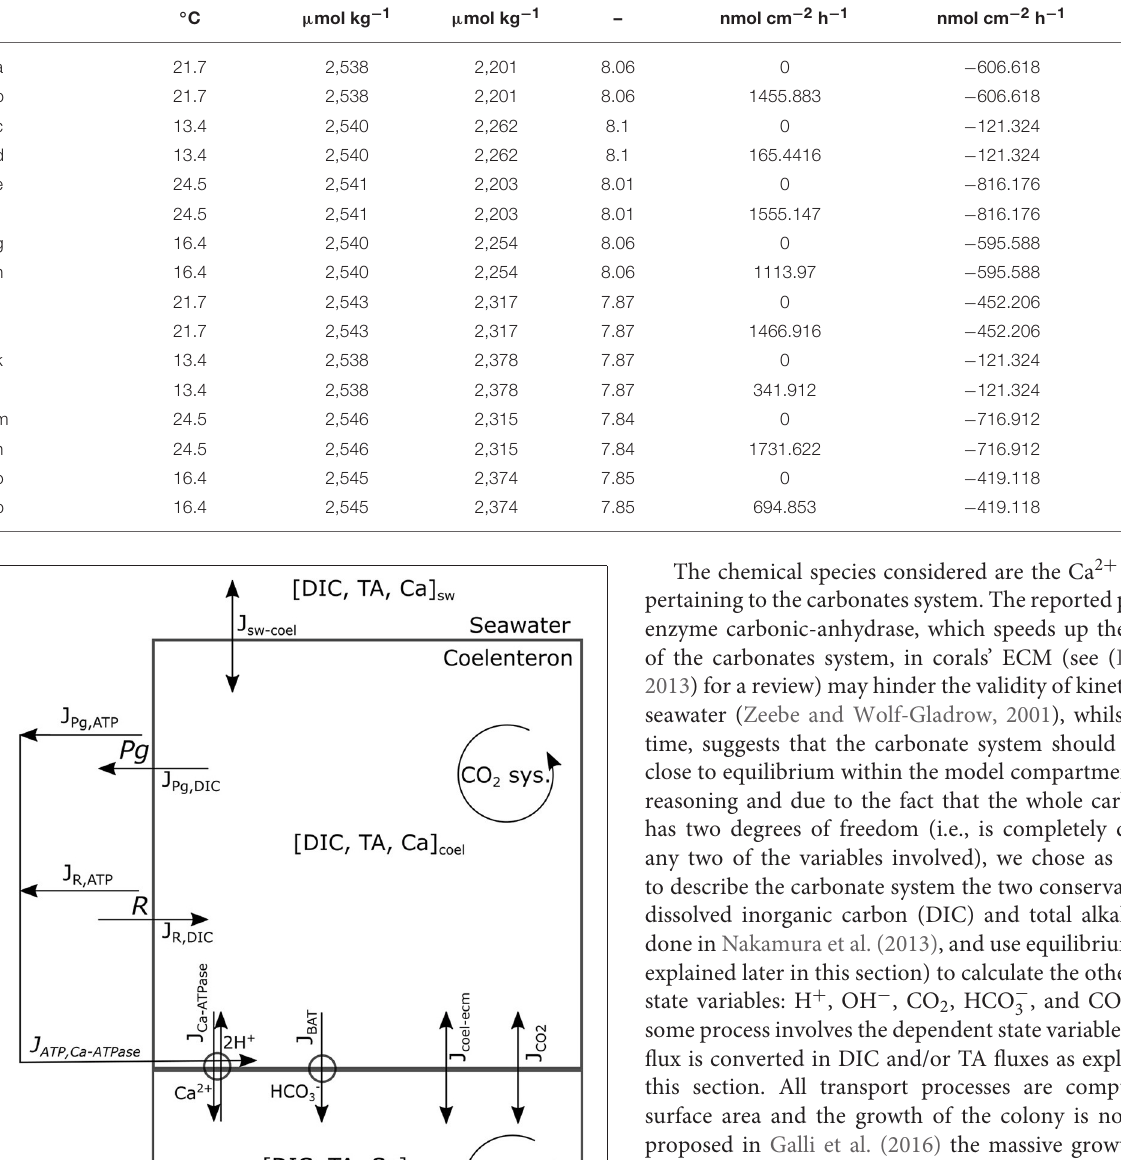
TABLE 1 | Experimental data from Rodolfo-Metalpa et al. (2010) used in this study, calcification rates are measured with the alkalinity anomaly technique. Treatment